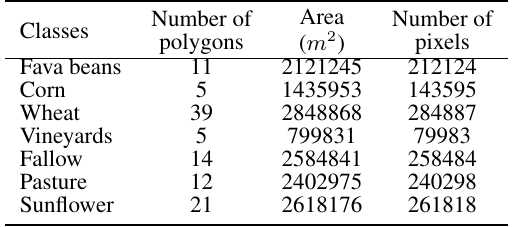
Table 1. Agricultural classes used for crop classification of the test area